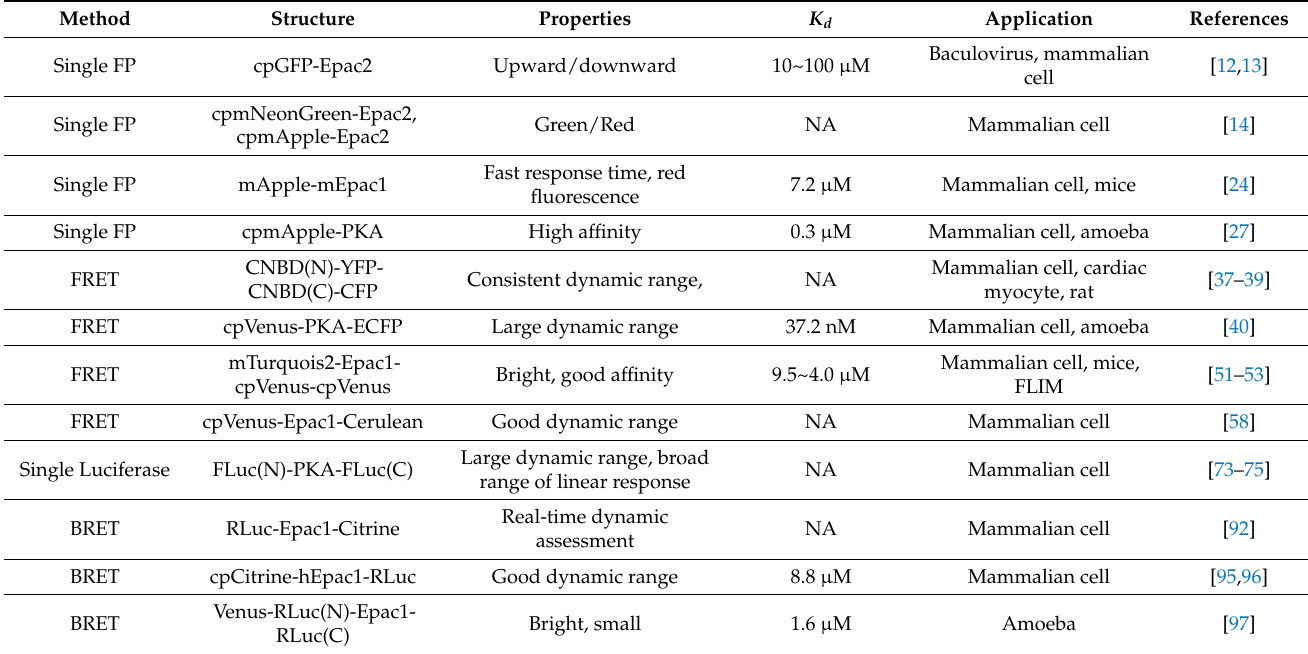
Table 1. Summary of some promising cAMP